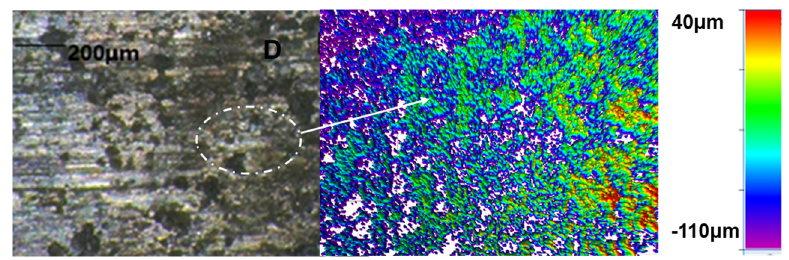
Figure 15. Resulting morphology of the damaged workpiece.